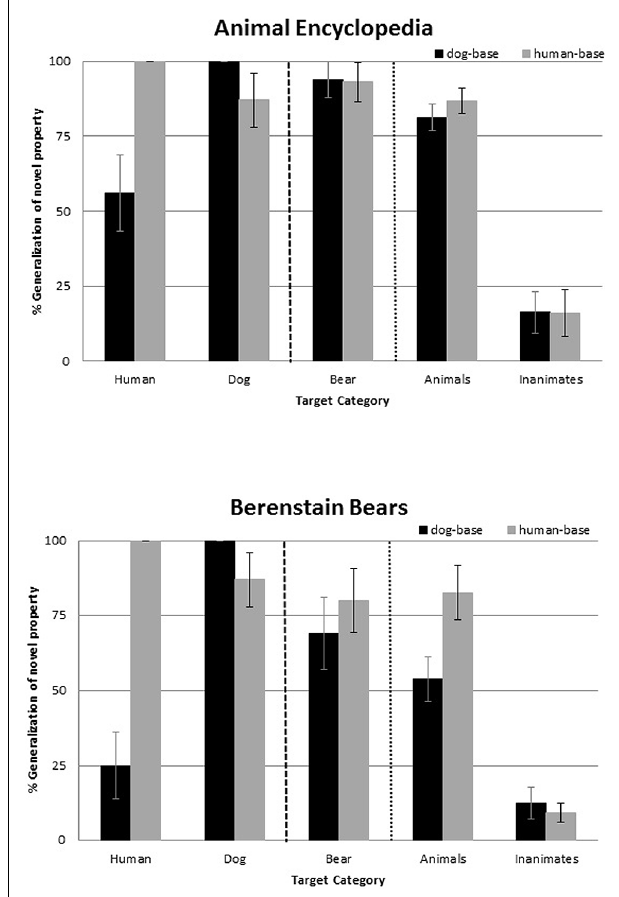
FIGURE 2 | Generalization to each target category, as a function of book and condition. Error bars depict standard error of the